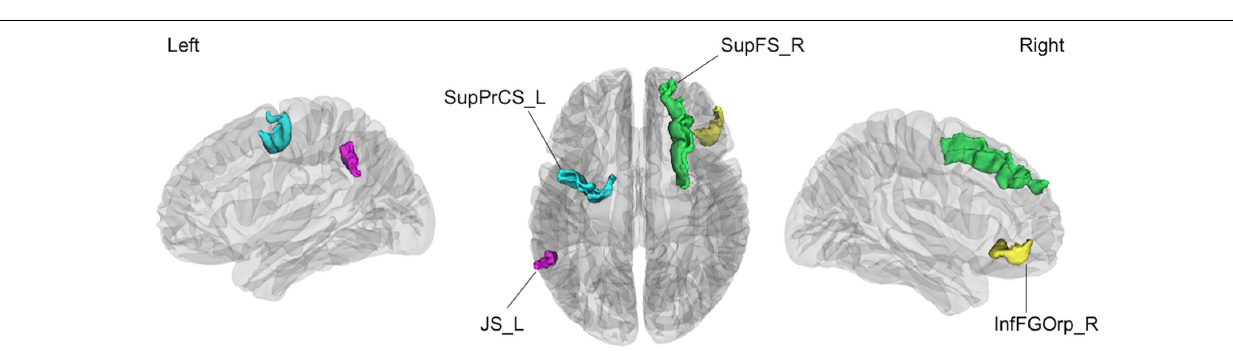
FIGURE 3 | The four cortical regions identified as consistent classification inputs were located within the cortical regions involved in cognitive functions essential for driving, such as voluntary orienting of attention, decision making, and working memory. SupPrCS_L, the left superior part of the precentral sulcus; JS_L, the left sulcus intermedius primus (of Jensen); InfFGOrp_R, the right orbital part of the inferior frontal gyrus; SupFS_R, the right superior frontal